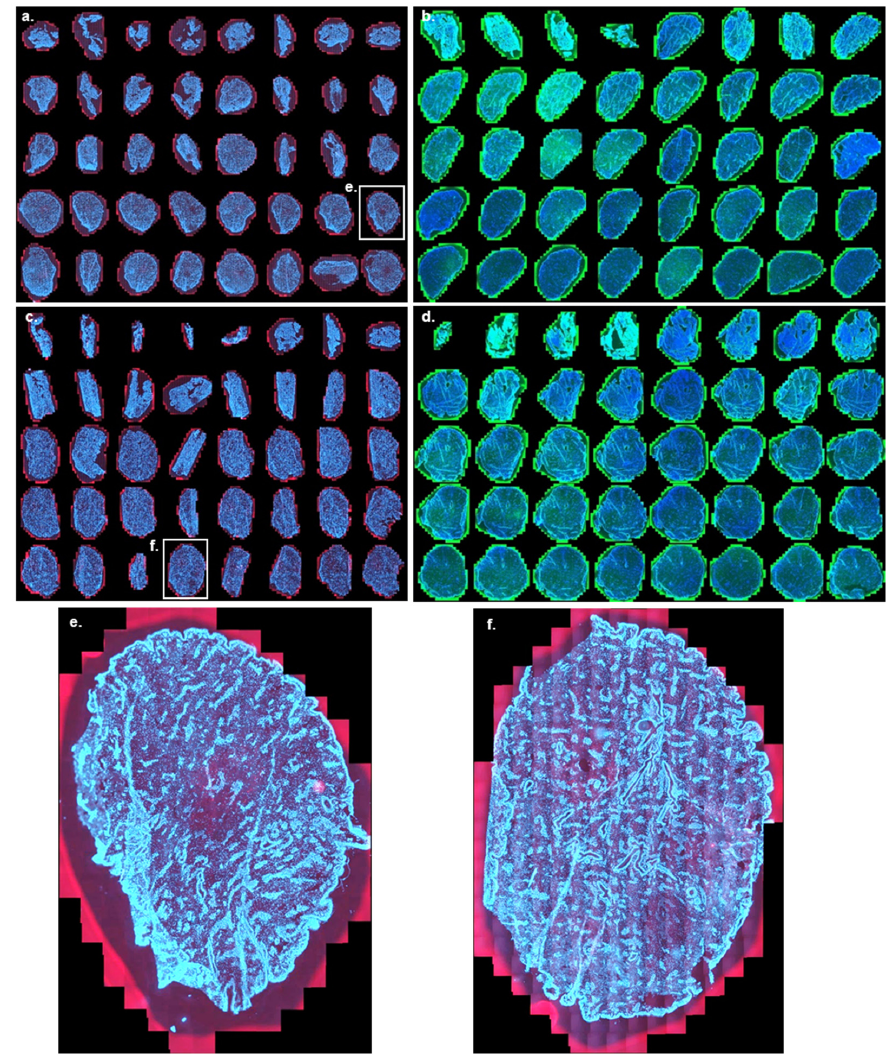
Figure 5. Cutaneous distribution as a function of depth of Cy5 labeled mRNA and eGFP after delivery of the former and eGFP expressing mRNA using the Dermojet ® jet injector system equipped with either 1 or 3 heads. The images show the Cy5 labeled mRNA (red), eGFP (green), and DAPI (blue) signal 24 h after delivery of the polymer formulations containing 1 µg of either Cy5 labeled mRNA or eGFP expressing mRNA using the Dermojet ® system. ( a , b ) Images of the Cy5 labeled mRNA and eGFP signals going from a skin depth of 10 to 400 µm after delivery of either the Cy5 labeled mRNA or the eGFP expressing mRNA using the Dermojet ® 1-head device; ( c , d ) Images of the Cy5 labeled mRNA and eGFP signals going from a skin depth of 10 to 400 µm after delivery of either the Cy5 labeled mRNA or the eGFP expressing mRNA using the Dermojet ® 3-head device. The results with the Dermojet ® jet injector are consistent with those seen after ID injection with Cy5 mRNA signal being predominantly present in the dermis and the eGFP signal being also strongly seen in the epidermis. Thus, the jet injector, despite being applied to intact skin, deposits mRNA in the dermis. ( e , f ) Close-up image of the Cy5 labeled mRNA signal from the dermal region—section 32, corresponding to a depth of 320 µ m—after application of the Dermojet ® 1-head device and—section 36, corresponding to a depth of 360 µ m—after using the Dermojet ® 3-head jet injector. The effect of using the 3-head device is clearly visible with the three discrete zones of Cy5 labeled mRNA. For panels ( a – d ), high resolution images are available in Supplementary Materials—File S2 —high resolution montages of all 40 skin